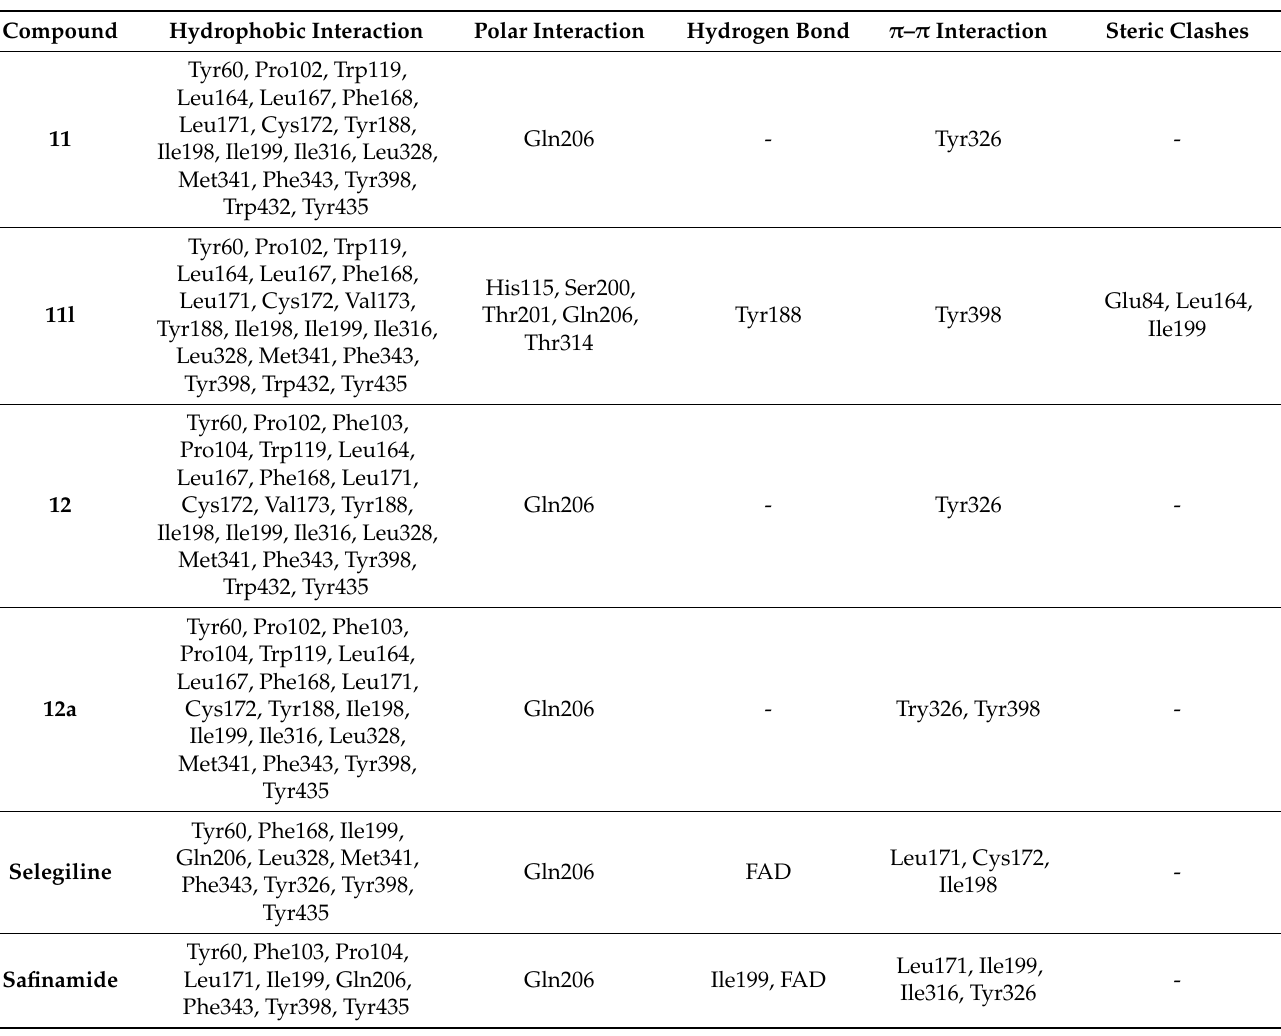
Table 2. Active MAO-B amino residues participated in the interactions with 11 , 11l , 12 , 12a , Selegiline and